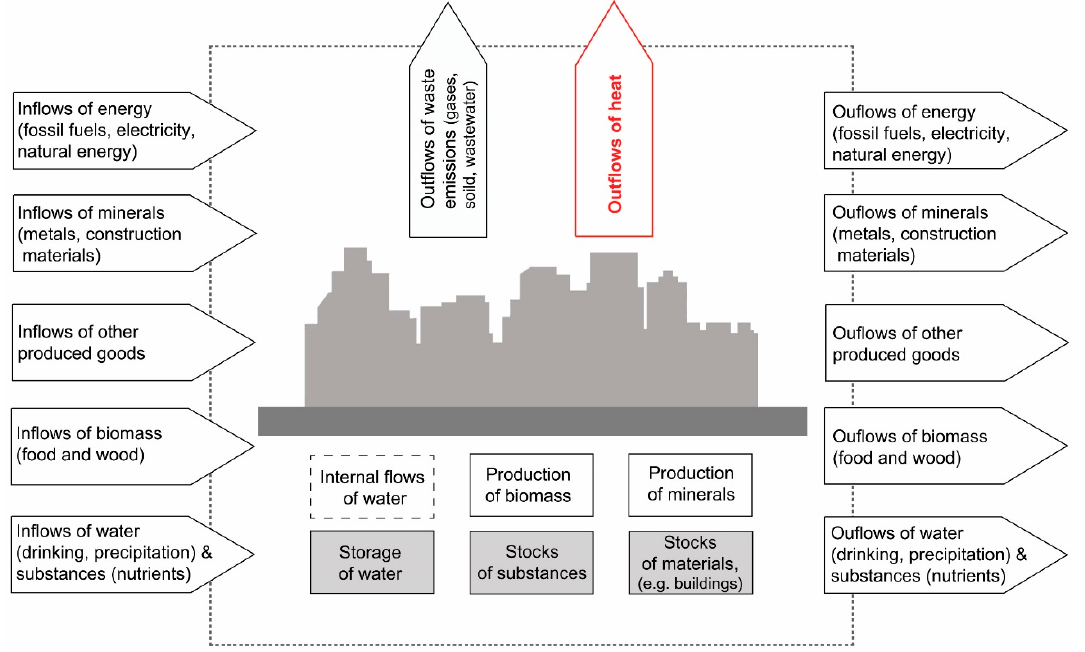
Figure 5. Extended EW-MFA framework including heat outflows among other emissions to air. Adapted from Kennedy and Hoornweg, 2012 [62].